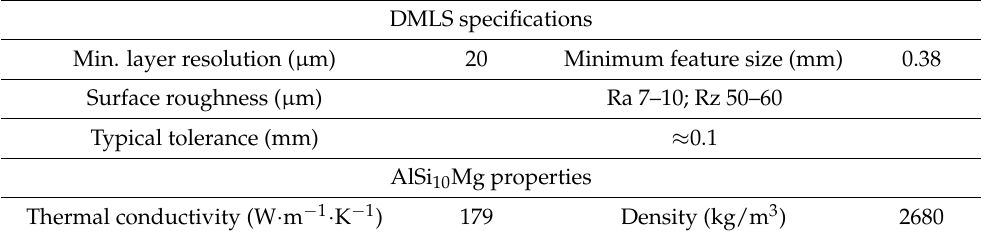
Table 2. Specifications of DMLS process and material properties.